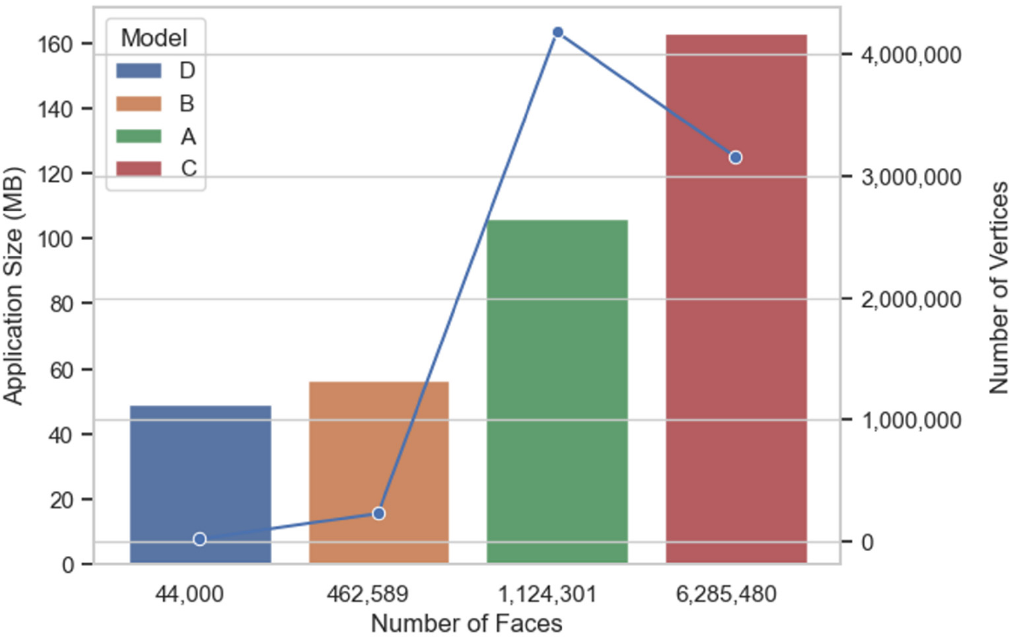
Figure 6. Relationship of the number of faces ( x -axis) and number of vertices (blue trend line) in relation to the size of the APP in MB ( y -axis).